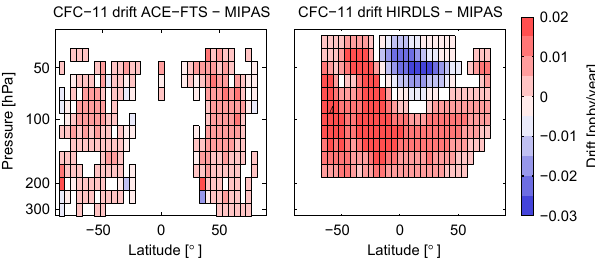
Figure 4. Altitude–latitude cross sections of drifts between ACE- FTS and MIPAS (left panel) and HIRDLS and MIPAS (right panel) CFC-11 climatologies are given in the form of the linear terms [ppbvyear − 1 ] derived from multi-linear regression of the difference time